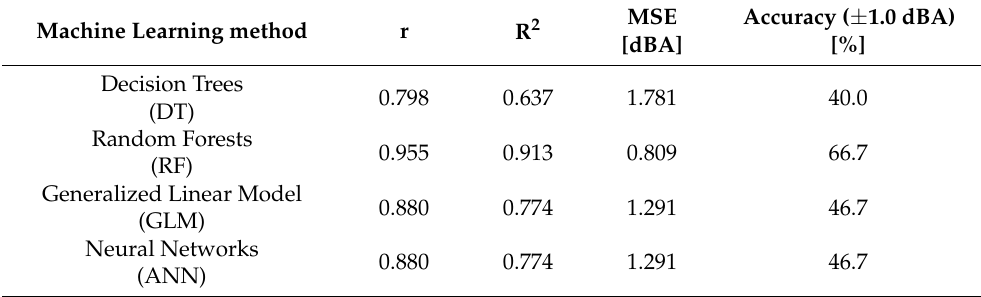
Table 6. Comparison of results for the prediction models (testing dataset) without considering